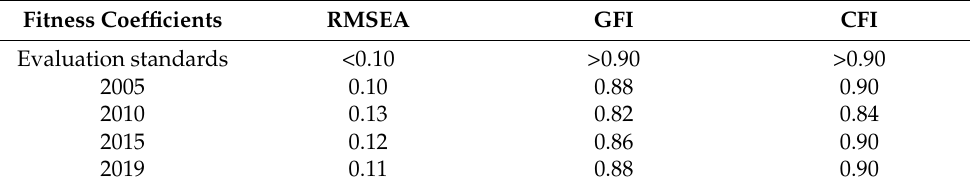
Table 2. Fitness coefficients from SEM. Fitness Coefficients RMSEA GFI CFI Evaluation standards <0.10